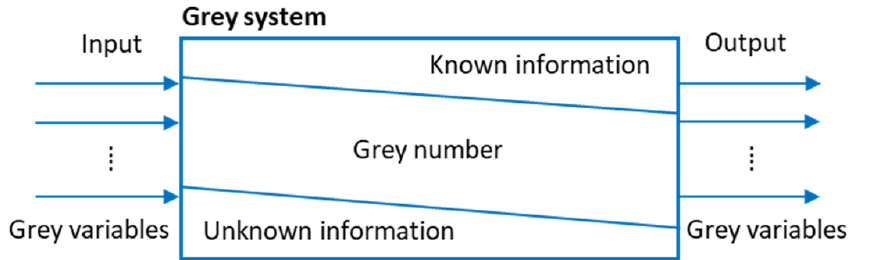
Figure 2. The concept of the grey system theory. A grey number is called by ⨂𝑥 = [𝑥, 𝑥] where 𝑥 and 𝑥 represent the lower bound and the upper bound of the membership function. The grey number’s exact value is un- known, but the interval range within which it falls is known. Let ⨂𝑥 (cid:2869) = [𝑥 (cid:2869) , 𝑥 (cid:2869) ] and ⨂𝑥 = [𝑥 , 𝑥 ] be two grey numbers, 𝑘 is a positive real number, and 𝐿 is the length of (cid:2870) (cid:2870) (cid:2870) grey numbers. The basic arithmetic operations are presented in Equations (1)–(6) as fol- lows: